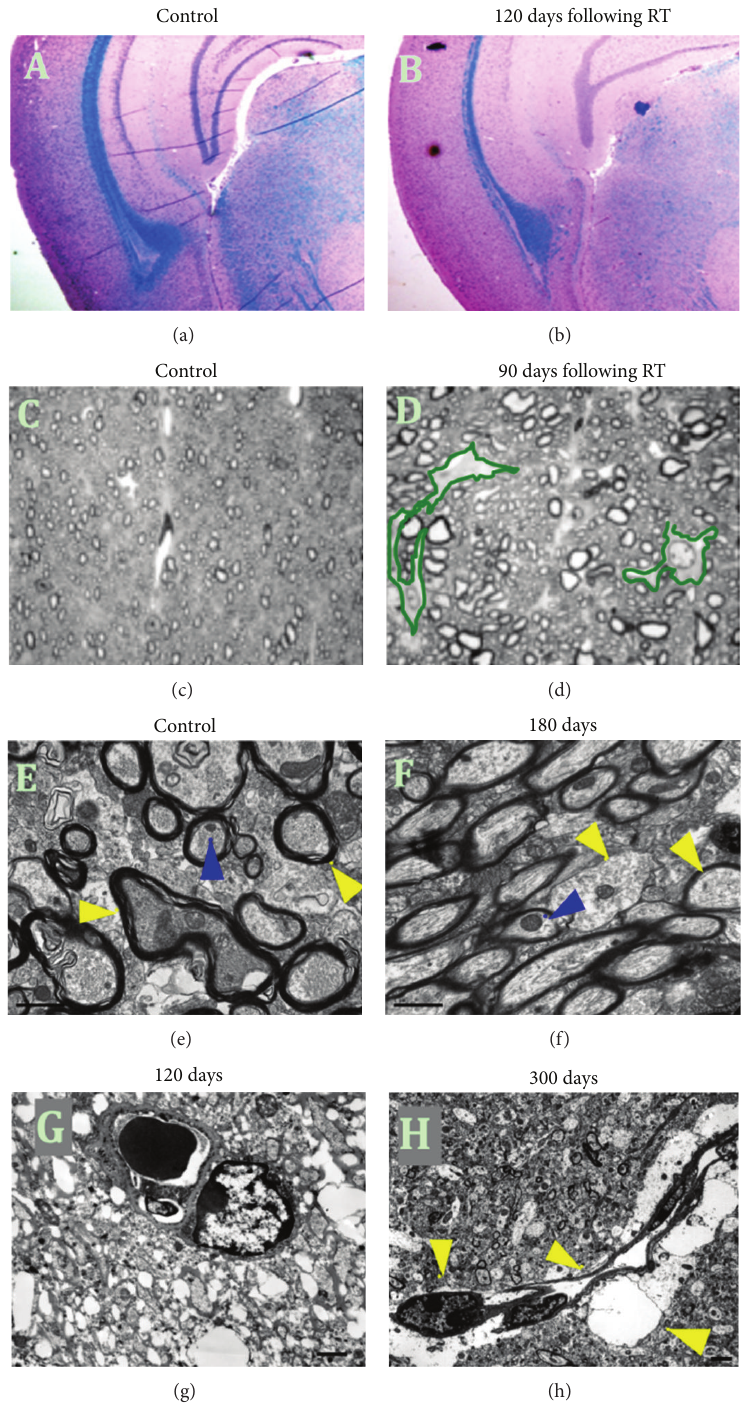
Figure 5: Histological markers of radiation injury in the mouse brain at 90, 120, 180, and 300 days after RT. (a, b) Luxol fast blue staining showing loss of myelin. (c, d) Sections of brain nerve fibers showing structural changes, microglial (outlined in green) inflammation, and myelin sheath thickening indicative of cell death (images at 50x). (e, f) Yellow and blue arrow heads point at myelin sheath surrounding the neurons and at mitochondria, respectively (scale bar = 1 𝜇 m). (g) Necrosis detected at 120 days. (h) Yellow arrows point at pericyte pulling away from endothelial cell, a sign of inflammation, with white edematous area causing vascular